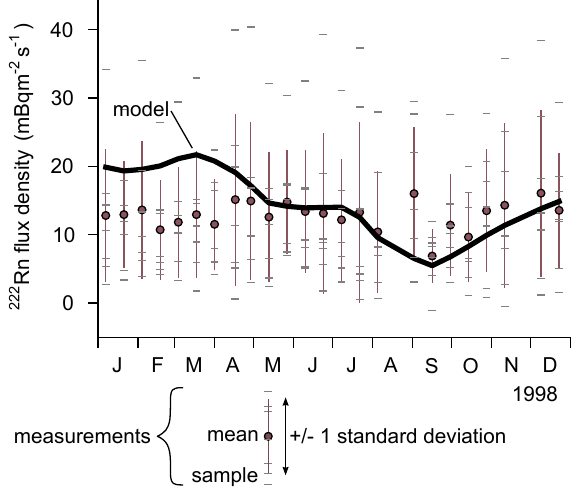
Fig. 5. Time series of measured and modelled radon flux den- sity during 1998 from the Cataract data set. The average flux den- sity over the entire year was measured to be 12.6mBqm − 2 s − 1 , whereas the uncalibrated model was 14.5mBqm − 2 s − 1